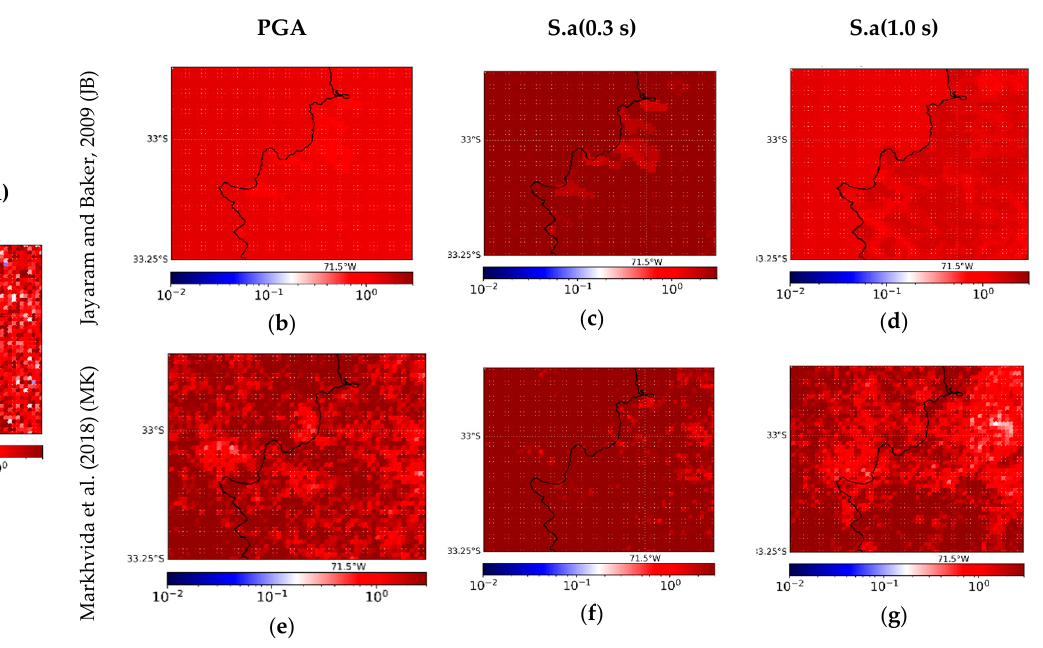
Figure 14. Single realisation of a ground motion field with the following conditions: ( a ) PGA uncorrelated; spatially correlated (JB) [97] for ( b ) PGA, ( c ) S.A(0.3 s), and ( d ) S.A(1.0 s); and cross-correlated (MK) [98] for ( e ) PGA, ( f ) S.A(0.3 s), and ( g ) S.A(1.0 s).